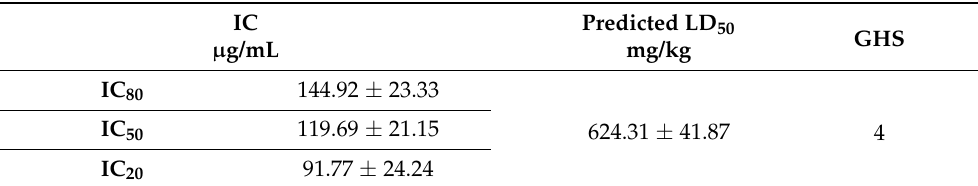
Table 1. Cytotoxicity evaluation of the AgNPs biologically synthesised by the fungus C. thermophilum using the NRU assay with the skin fibroblasts from the murine embryo Balb/c 3T3 NIH cell line: IC values, the predicted LD 50 (which, given all at once, could cause the death of 50% of a group of test animals) and the GHS for the AgNPs’ cytotoxic effects.